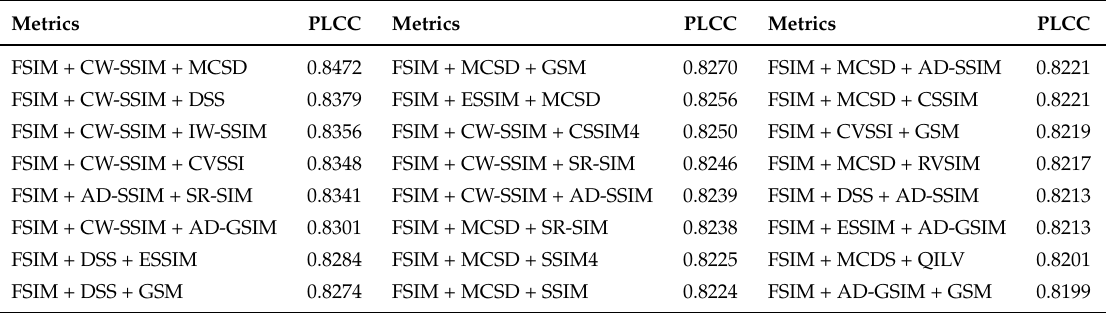
Table 3. The PLCC values obtained for 107 images using 24 “best” combinations of three elementary metrics assuming the division into 16